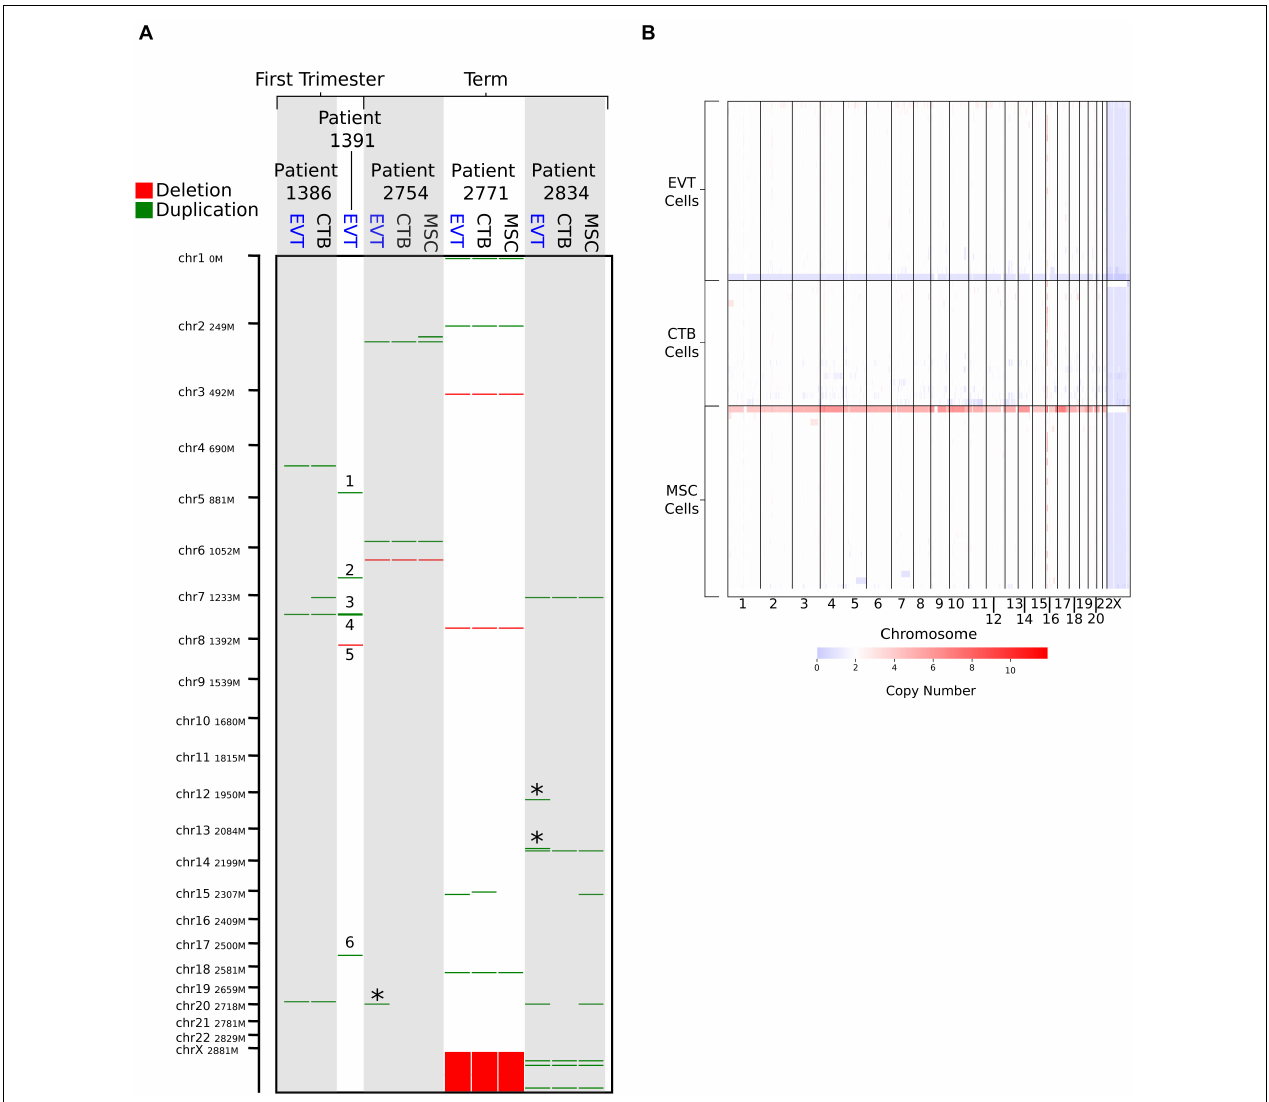
FIGURE 1 | Copy number variation (CNV) analysis using genome-wide SNP genotyping array and single-cell CNV data. (A) CNV analysis on matched cytotrophoblast (CTB), extravillous trophoblast (EVT), and umbilical cord-derived mesenchymal stem cells (MSC) from three term placentae, and matched CTB and EVT from two first trimester placentae, using genome-wide SNP genotyping array (CTB sample from Patient 1,391 was removed due to poor data quality). Deletions are shown in red and duplications in green. “ ∗ ” indicates duplications that are unique to term EVT. Numbered CNVs are those potentially unique to first trimester EVT, though no matched CTB sample was available for Patient 1,391 for direct comparison. Patient 2,771 is female, and all other patients are male. (B) CNV calls from single-cell CNV analysis on matched CTB, EVT, and MSC from a single term placenta sample (Patient 2,757—male). Red on the heatmap represents increase in copy number and blue a loss in copy number. White represents a copy number of